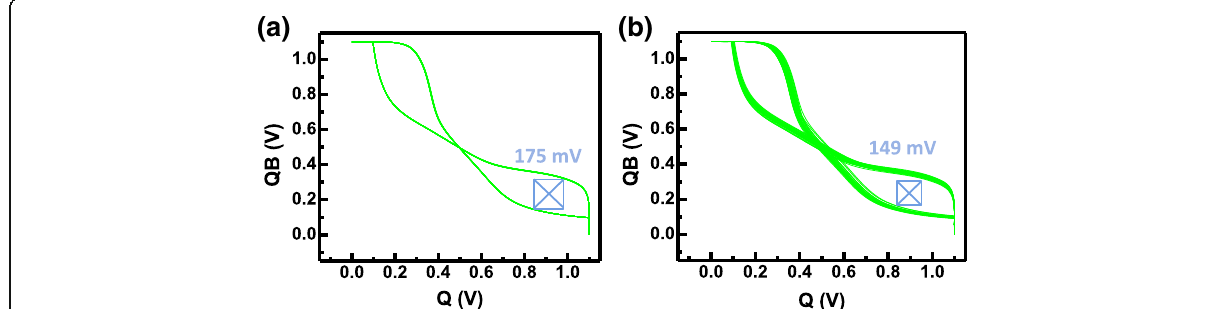
Fig. 14 Butterfly curves by Monte-Carlo simulations comparing SNM degradations caused by a variation in R L,L after initialization and b variations in both R L,L and V